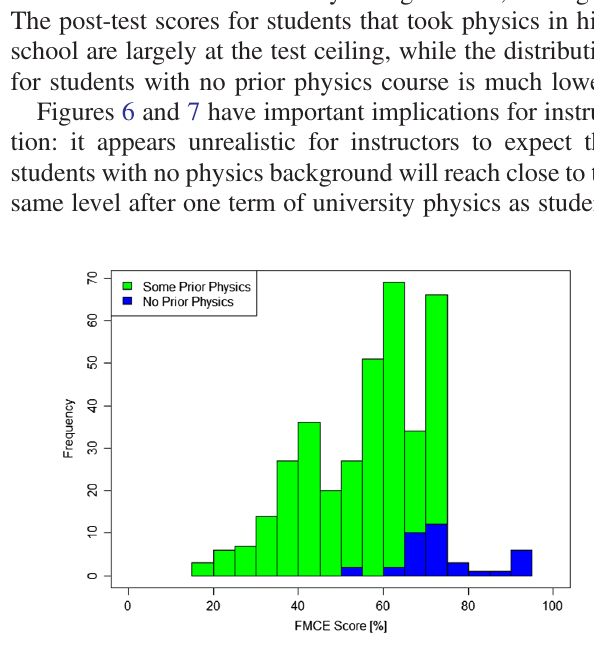
FIG. 6. FMCE score after first physics course, controlling for math SAT scores. Green bars represent the distribution of scores for students who took physics in high school ( N ¼ 337 ), and blue bars represent those students with no physics in high school ( N ¼ 37